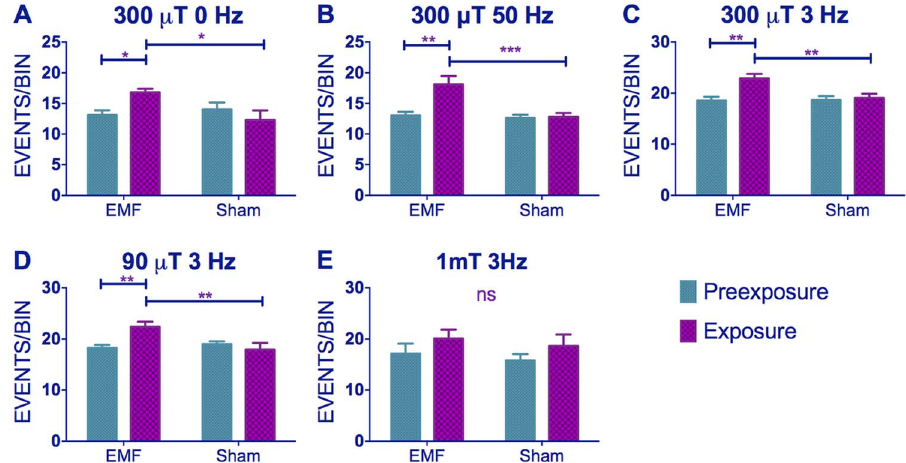
Figure 4. EMFs increase activity levels in wild-type flies. (A–C) Hyperactivity in EMF-exposed CS under static, 50 and 3 Hz field respectively at 300 m T. (C–E) Hyperactivity in CS flies under 300, 90 and 1000 m T field respectively at 3 Hz. N’s are the same as in Figure 1. Mean activity events per 30 min time bin ( 6 sem). For average activity and N refer to Table S2 ( post-hoc *p , 0.05, **p , 0.01, ***p , 0.001).